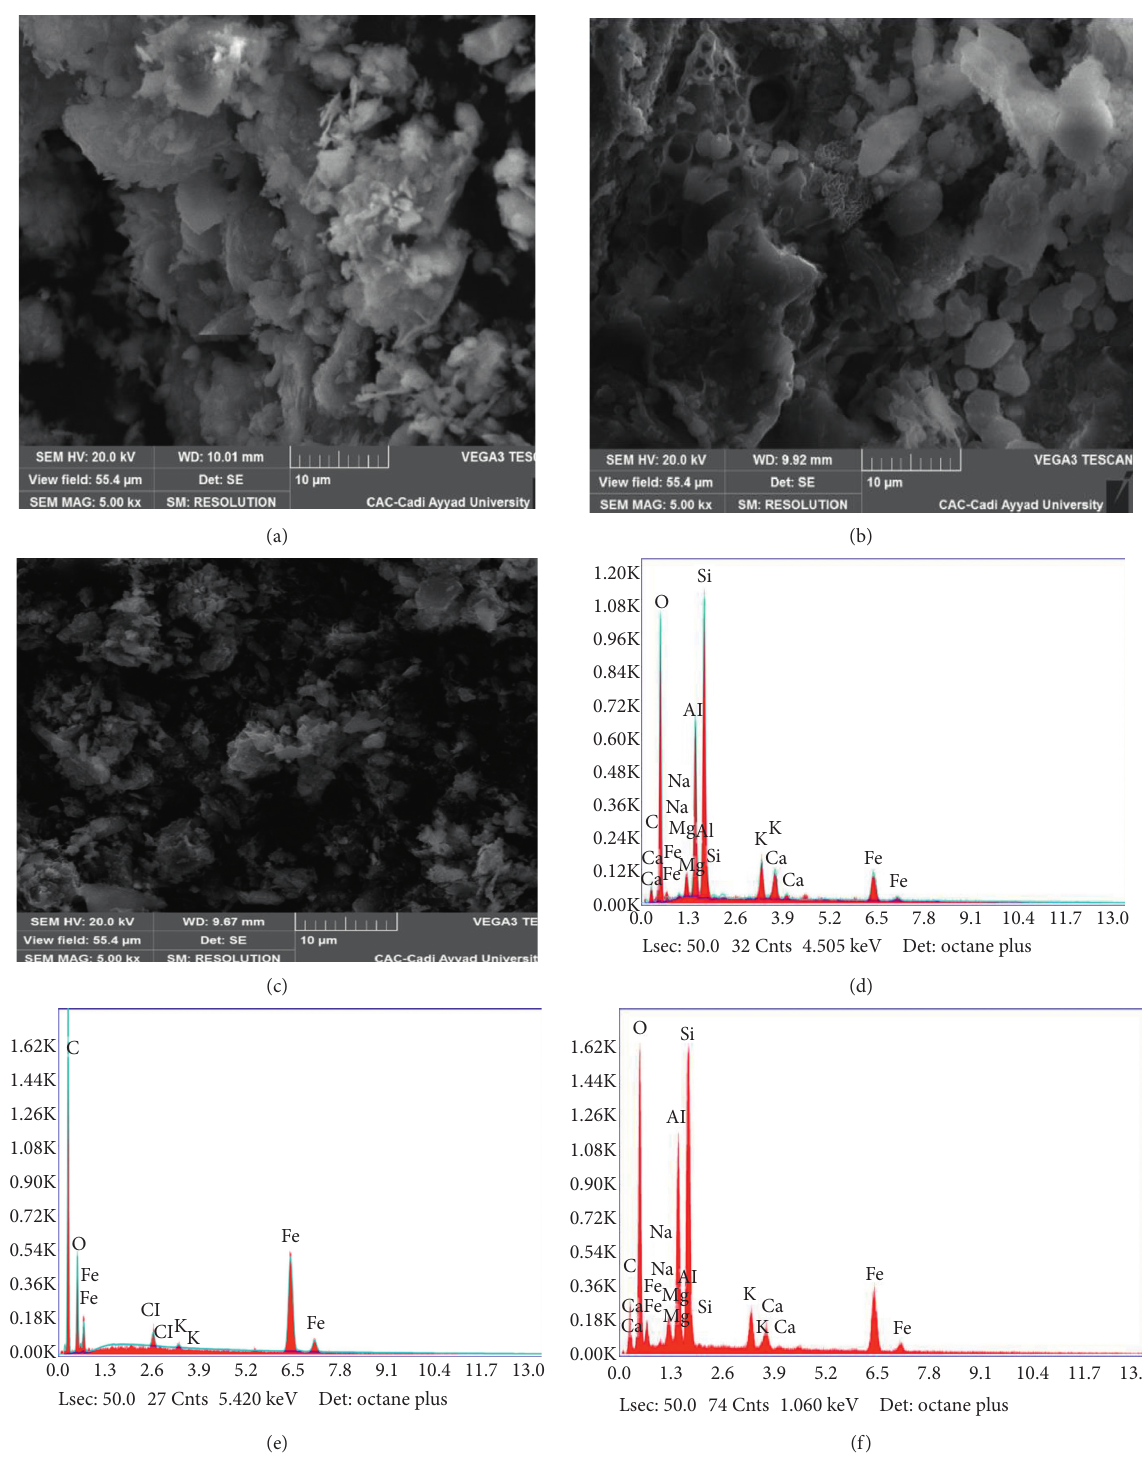
Figure 5: (a) SEM micrographs of HS, (b) HC-Fe and (c) 2:1 composite, (d) EDS of HS, (e) HC-Fe, and (f) 2 :1